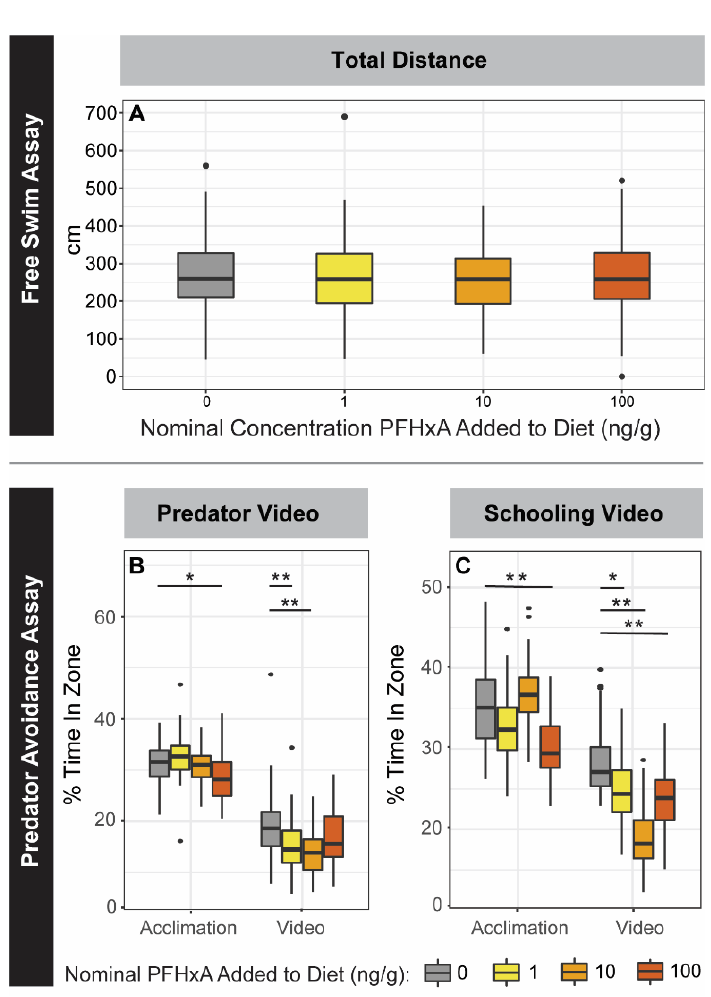
Figure 5. Anxiety Behaviors for F0. F0 zebrafish were challenged with adult behavior free swim ( A ), predator response ( B ), and schooling response assays ( C ). Exposure groups are indicated on the x-axes and by color (left to right, grey: 0 ng/g, yellow: 1 ng/g, orange: 10 ng/g, and red: 100 ng/g PFHxA added to the diet). PFHxA juvenile dietary exposure did not affect the total distance traveled in the free swim assay ( n = 66–68). The predator and schooling response plots show the percent time (cumulative duration) spent in the near zone (i.e., closest to the video display). For both predator and schooling response ( n = 65–68), time spent was significantly decreased for all groups after video display (Video) compared to before (Acclimation). Significant differences between exposure groups within the Acclimation and Video periods are indicated on the plots (* p < 0.05; ** p <